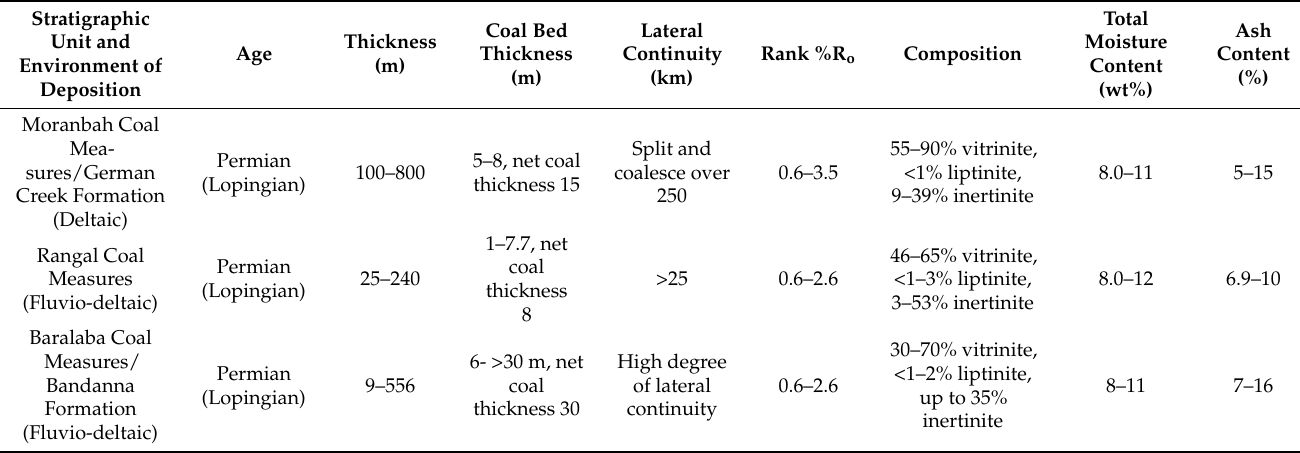
Table 2. Summary of key geological characteristics of CSG-bearing units in the Bowen Basin [22,40,49,53,57,63,64]. Stratigraphic Unit